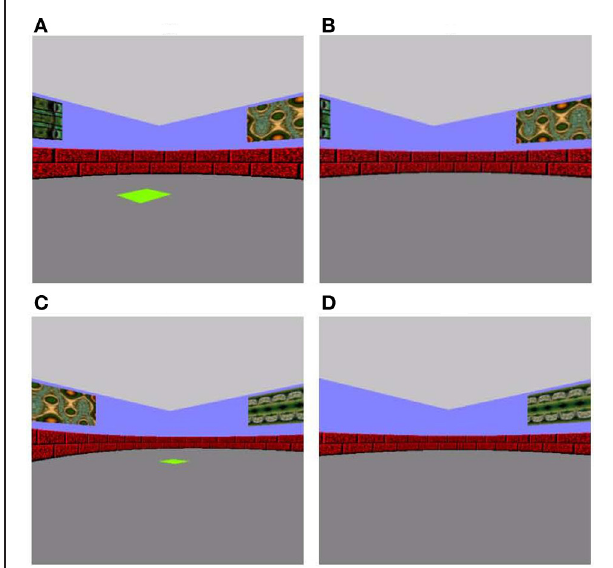
FIGURE 1 | Associative memory training task (A and B) and spatial pattern completion (C and D) tasks. (A) In the sample phase of the training task, participants navigated using the arrow keys on keyboard to a green square. (B) During the choice phase, they were required to navigate to the same location the green square was previously presented in, this time in the absence of a visible green square. (C) The sample and (D) choice phases for spatial pattern completion were similar to the training phase, except the number of wall cues available was manipulated such that 0, 2, or all 4 wall cues were missing in the choice phase of spatial pattern completion.